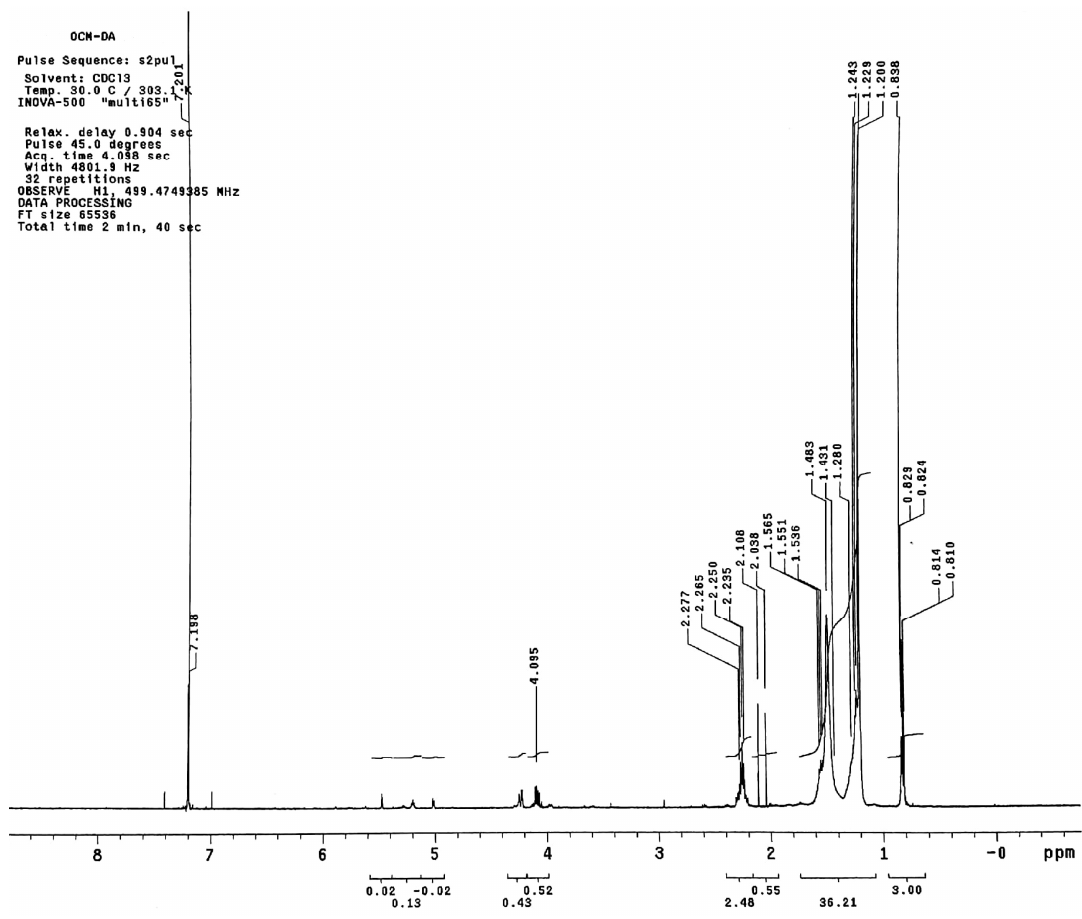
Figure 2. The 1 H-NMR spectrum of B. glabra oil degummed with H 3 PO 4 (CDCl 3 , 500 MHz).